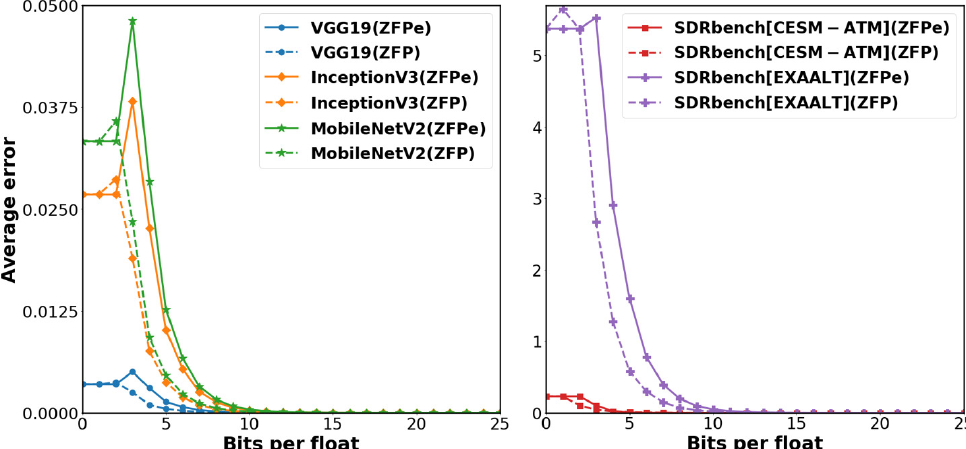
Figure 7. ZFPe shows comparable error rates compared to original ZFP across scientific and neural network